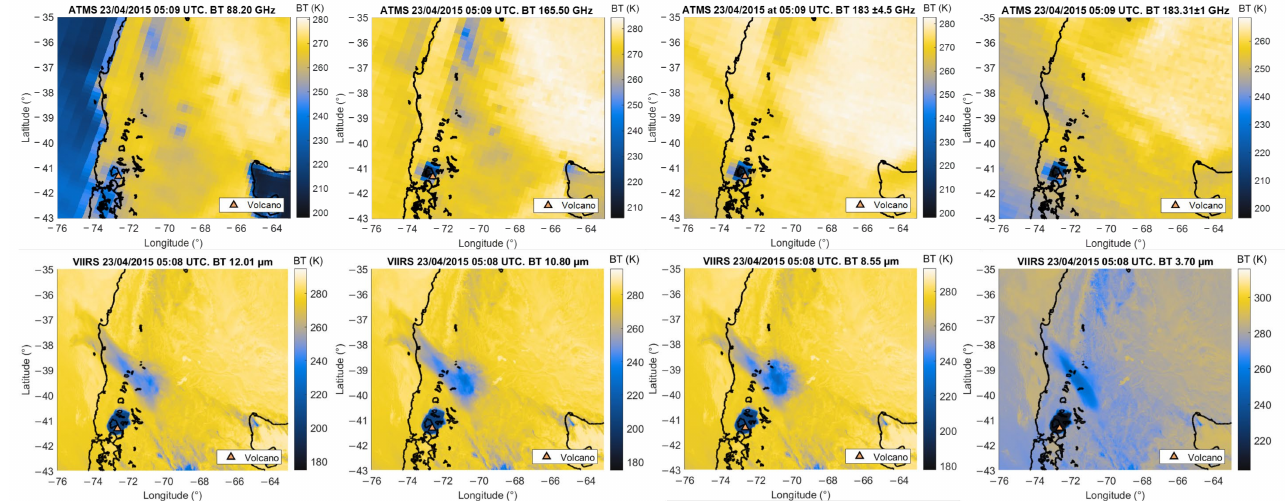
Figure 7. The Suomi-NPP Calbuco eruption on 23rd April 2015 at 05:09 UTC. ( First row ) ATMS brightness temperature at frequencies 88.20, 165.50, 183.31 ± 4.50 and 183.31 ± 1 GHz. ( Second row ) VIIRS brightness temperature at wavelengths 12.01, 10.80, 8.55 and 3.70 µ m. The volcanic cloud is characterised by darkest blue and black pixels for both MW-MMW and TIR signatures. In the VIIRS images, the dispersed volcanic cloud is highlighted by light blue